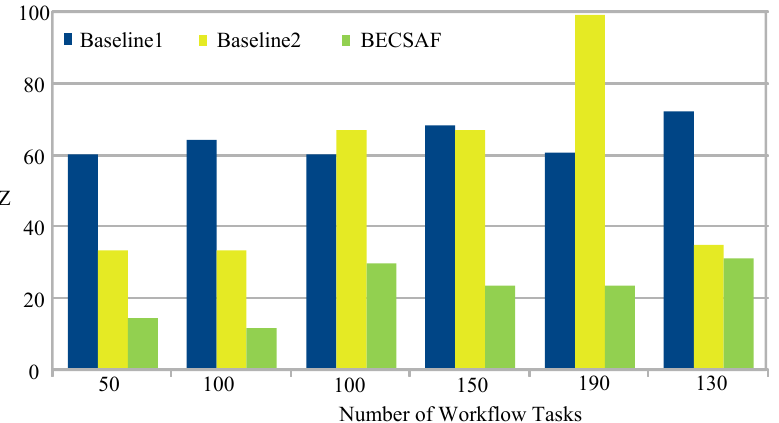
Figure 11. Proof of Sake for IoMT workflow Transactions in Blockchain-Enabled Fog-Cloud Network.